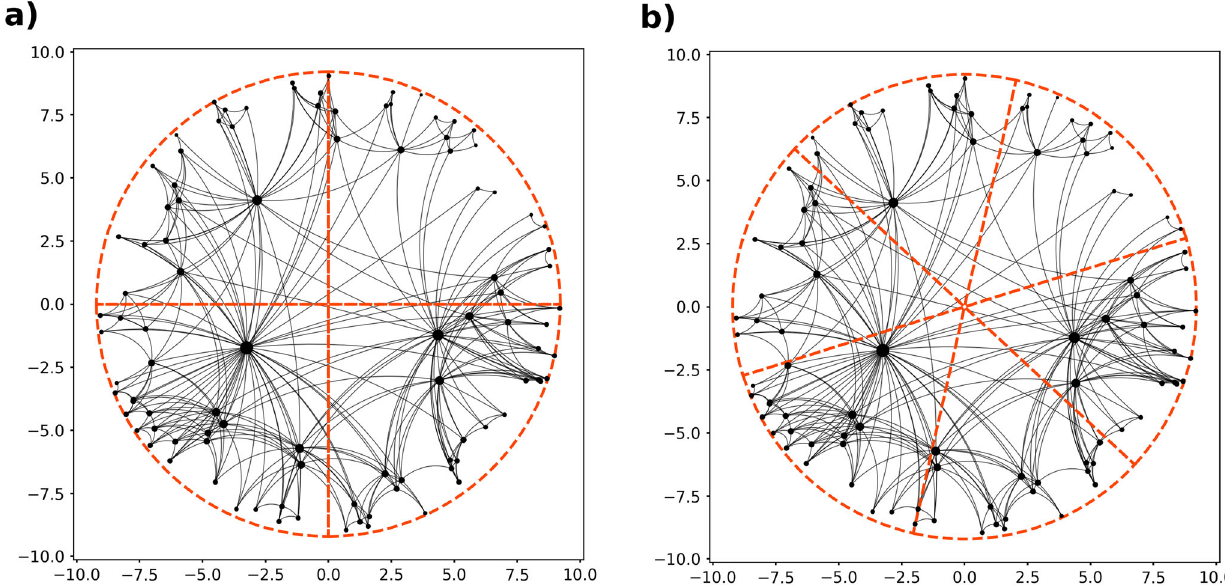
-- k ¼ 8 and N = 100 nodes,